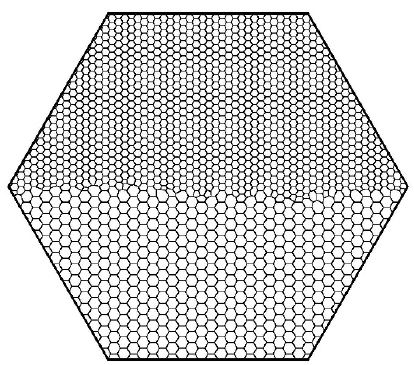
Figure 2. A picture of a 2D wet foam containing an incommensurate grain boundary.